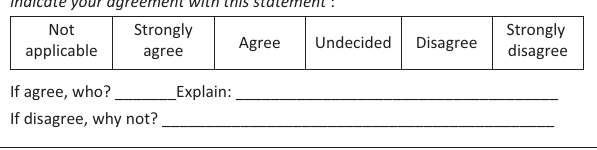
FIGURE 1: Example of a Likert-scale question used in a survey via interview.